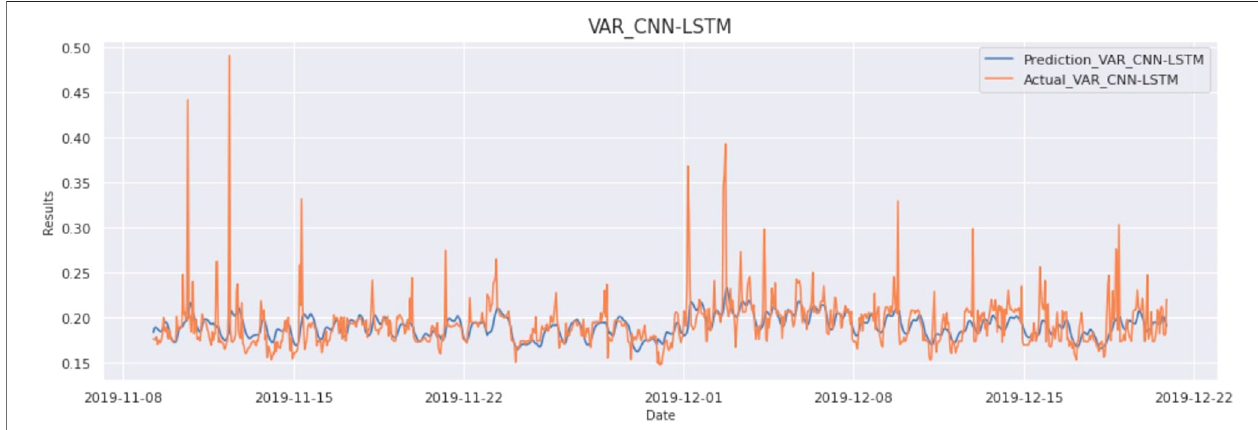
FIGURE 11 | Prediction vs Actual result of VAR CNN-LSTM model (Ontario Demand